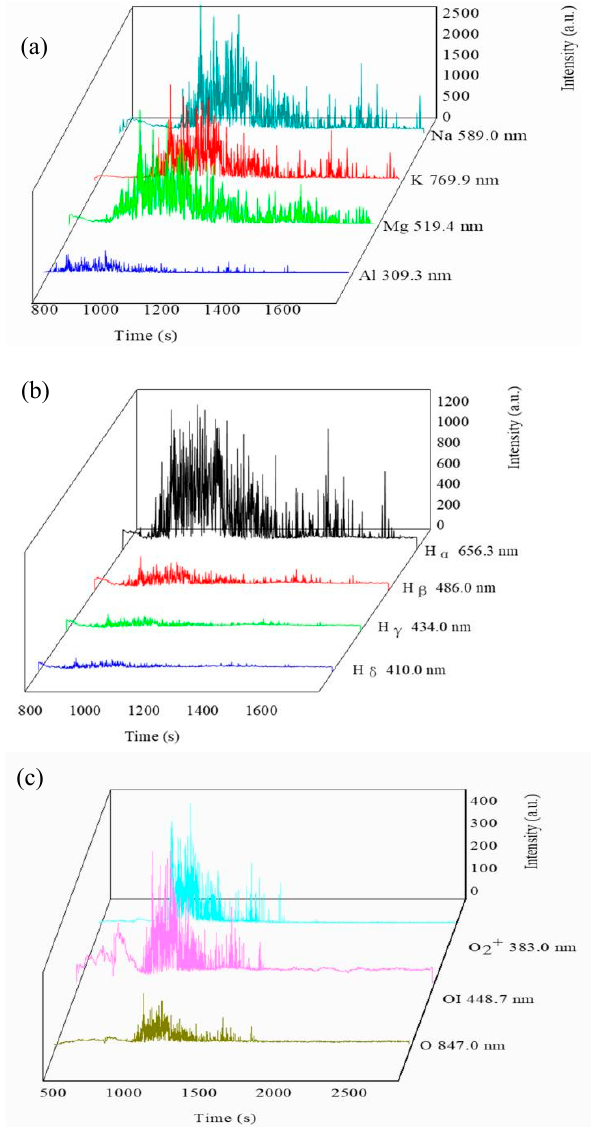
Figure 5. The intensity variation of each special plasma species with the time. ( a ) Metal elements; ( b ) Balmer lines of hydrogen; ( c ) oxygen elements. Table 1. List of the observed molecular bands, the corresponding transitions, and the wave- lengths. Species λ (nm) Transition